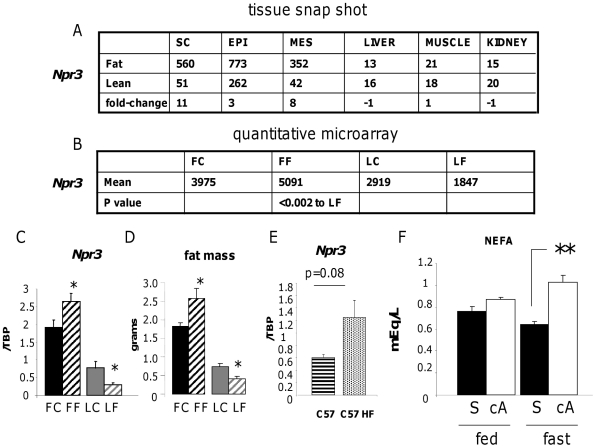
Validation and functional investigation of the candidate obesity gene Npr3.
A. Snap-shot pooled transcriptome microarray chip intensities (arbitrary units) across subcutaneous (SC), epididymal (EPI), mesenteric (MES) adipose tissues versus liver, muscle and kidney in Fat (F) and Lean (L) mice with the rounded expression ratio in bold. B. Mean chip intensity from quantitative microarray (n = 4) in Fat and Lean mice fed control (FC, LC) or high fat diets (FF, LF) with relevant P value for significant differences. C. RT-PCR validation of changes in Npr3 gene expression along with its relationship to D. Altered fat mass in response to high fat diet in subcutaneous adipose tissue of control diet-fed Fat (FC, black bars), high fat diet-fed Fat (FF, black hatched bars), control diet-fed Lean (LC, grey bars) and high fat diet-fed Lean (LF, grey hatched bars) mice. * = P<0.05 significant effect of diet within a line. E. Expression levels of Npr3 in subcutaneous fat of control diet (horizontal hatched bar) or HF fed (heavily stippled bar) C57BL/6J mice (C57). F. The effects of fasting (fast) on plasma free fatty acid levels (NEFA) in C57BL/6J mice implanted with minipumps releasing saline (S) or 100 ng/day cyclic ANP3-23 (cA). ** = P<0.01 for an effect of cA treatment of fasting NEFA.